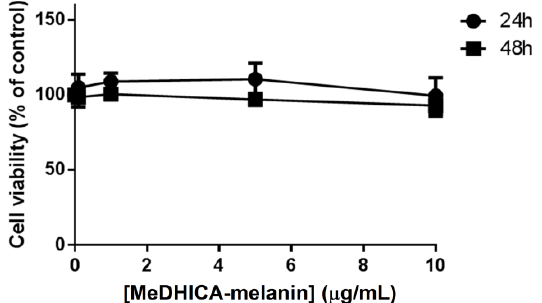
Figure 3. Effects of MeDHICA-melanin on HaCaT cells viability . Dose-response curves after 24 h (black circles) and 48 h (black squares) incubation of HaCaT cells with increasing concentration of MeDHICA-melanin (0.1–10 µg/mL). Cell viability was assessed by the MTT assay and cell survival expressed as percentage of viable cells in the presence of MeDHICA-melanin, with respect to control cells (i.e., cells grown in the absence of the melanin). The results shown are means ± SD of three independent experiments.